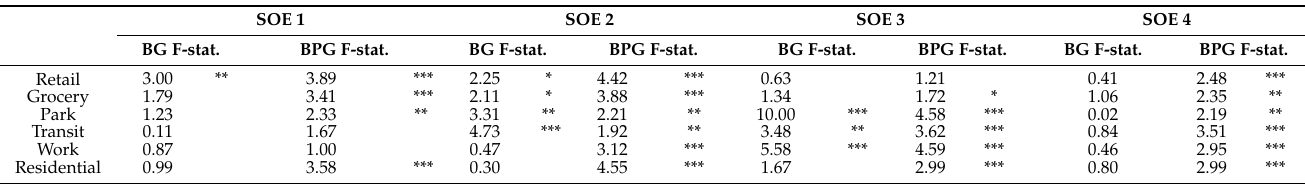
Table 4. Heteroskedasticity and autocorrelation